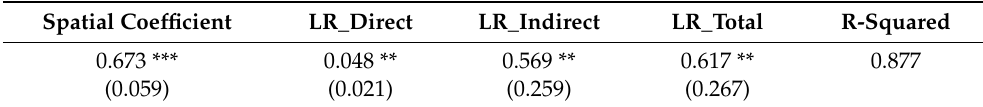
Table 6. Results of the spatial econometric model. Spatial